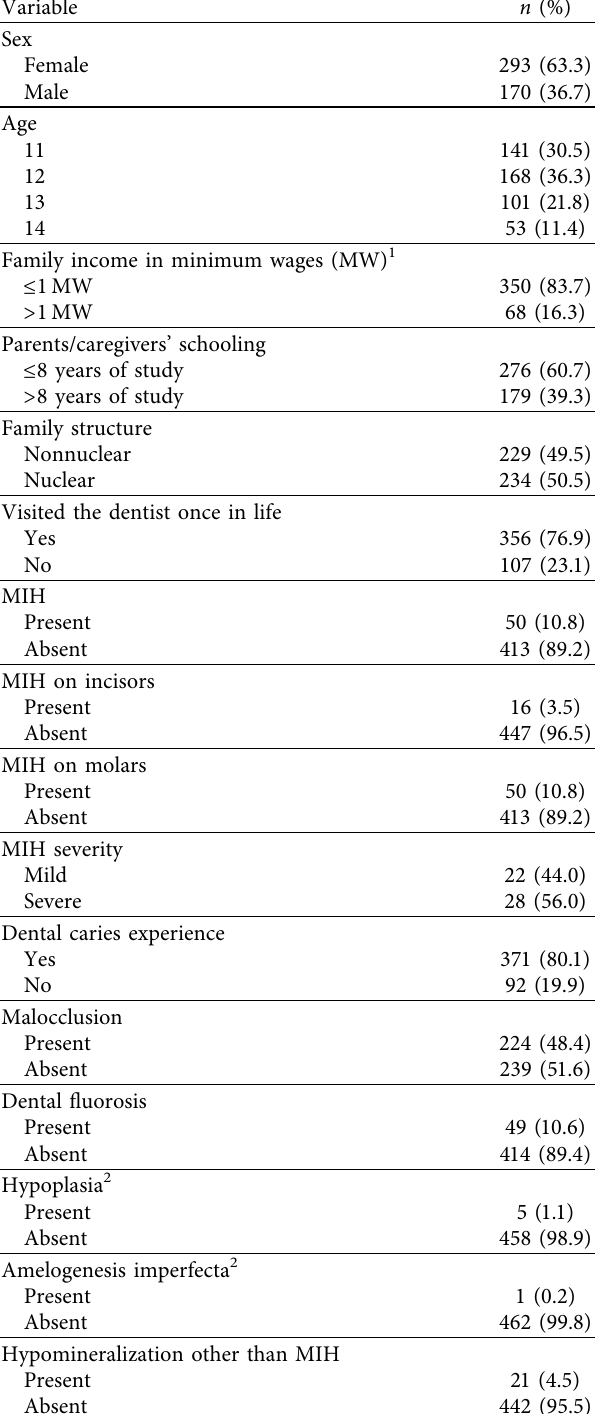
Table 1: Sample characterization regarding sociodemographic, economic, and clinical